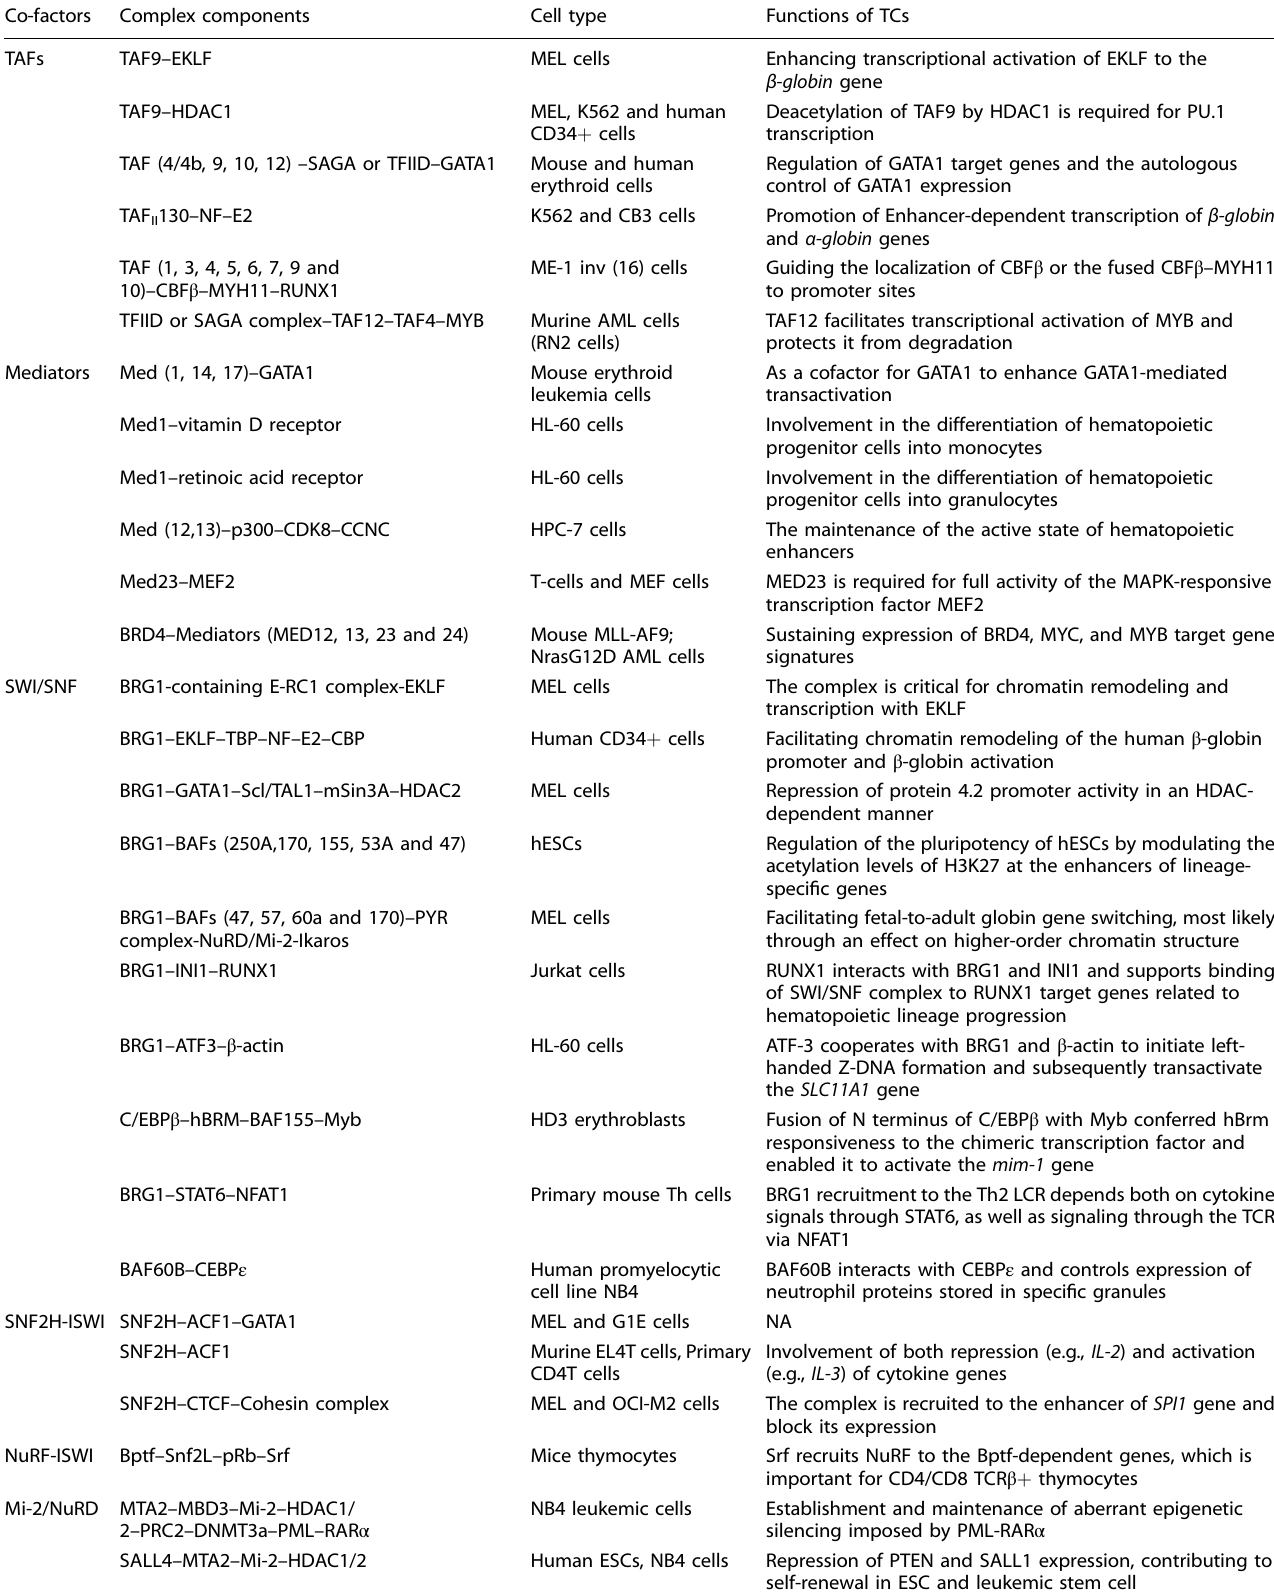
Table 1. Transcriptional complexes of TAFs, Mediators, and chromatin remodeling-related cofactors in normal and malignant hematopoietic cells and their